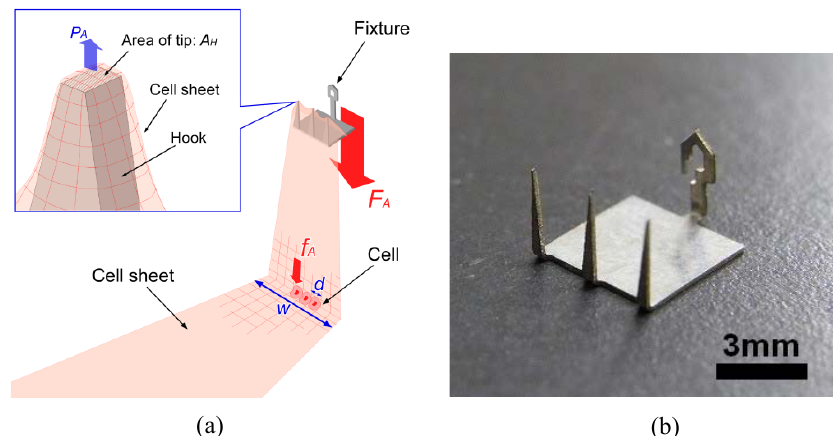
(b) bution of force at the fixture. (b) Photo of ercing